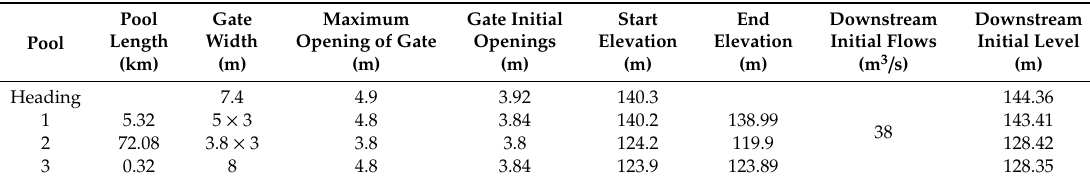
Figure 1. Layout of the case canal segment. Table 1. Basic parameters of each pool.